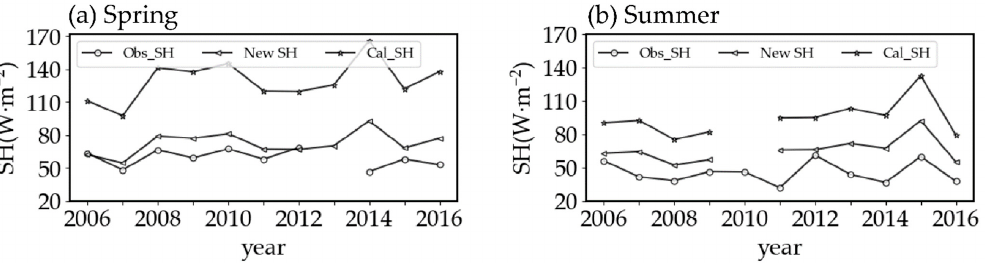
Figure 10. Time series of the annual mean in observed SH (Obs_SH, units: W m − 2 ), originally calculated SH (Cal_SH, units: W m − 2 ), and new SH (New SH, units: W m − 2 ) in ( a ) spring and ( b ) summer at NAMORS during the period 2006–2016.